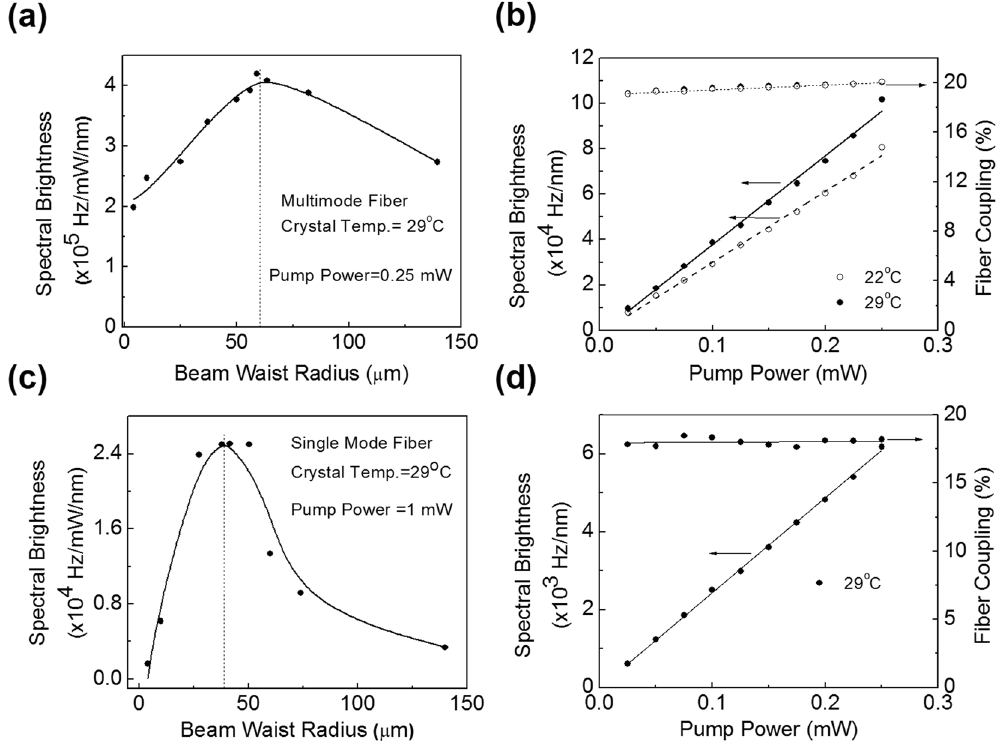
Figure 2. Characteristics of the degenerate, non-collinear SPDC source. ( a ) Dependence of spectral brightness of the paired photons on the pump beam waist at crystal temperature of 29 °C, and ( b ) the variation of spectral brightness and fiber coupling efficiency on the pump power at crystal temperature 22 °C (open circles) and 29 °C (solid circles) for photon collection using multimode fiber. Similarly, for photon collection using single mode fiber, ( c ) dependence of spectral brightness of the paired photons on the pump beam waist, and ( b ) the variation of spectral brightness and fiber coupling efficiency with the pump power at crystal temperature of 29 °C. Lines are guide to the